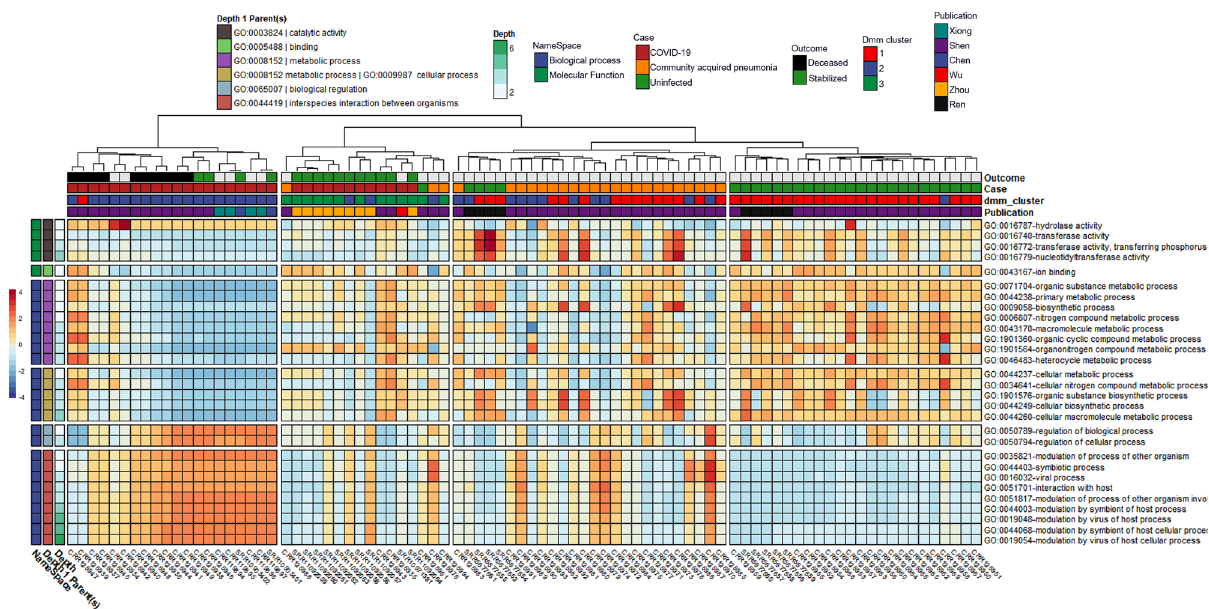
Figure 1. Heatmap with notable microbially-derived gene ontology functional annotations associated with COVID-19 (n =32), as compared to community acquired pneumonia (n = 29) & uninfected (n=25) cohorts. Cells are colored via z-scale calculations of the total read counts for each GO term by sample. Rows are sorted by parental GO terms (depth = 1), and columns are clustered by Euclidean distance using ward D2 clustering. Comparisons were conducted using MaAsLin2, controlling for publication and patient ID with Benjamini Hochberg multiple test comparison (q <